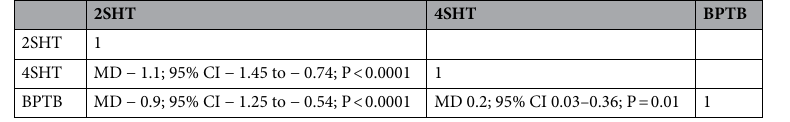
Table 3. Return to sport.